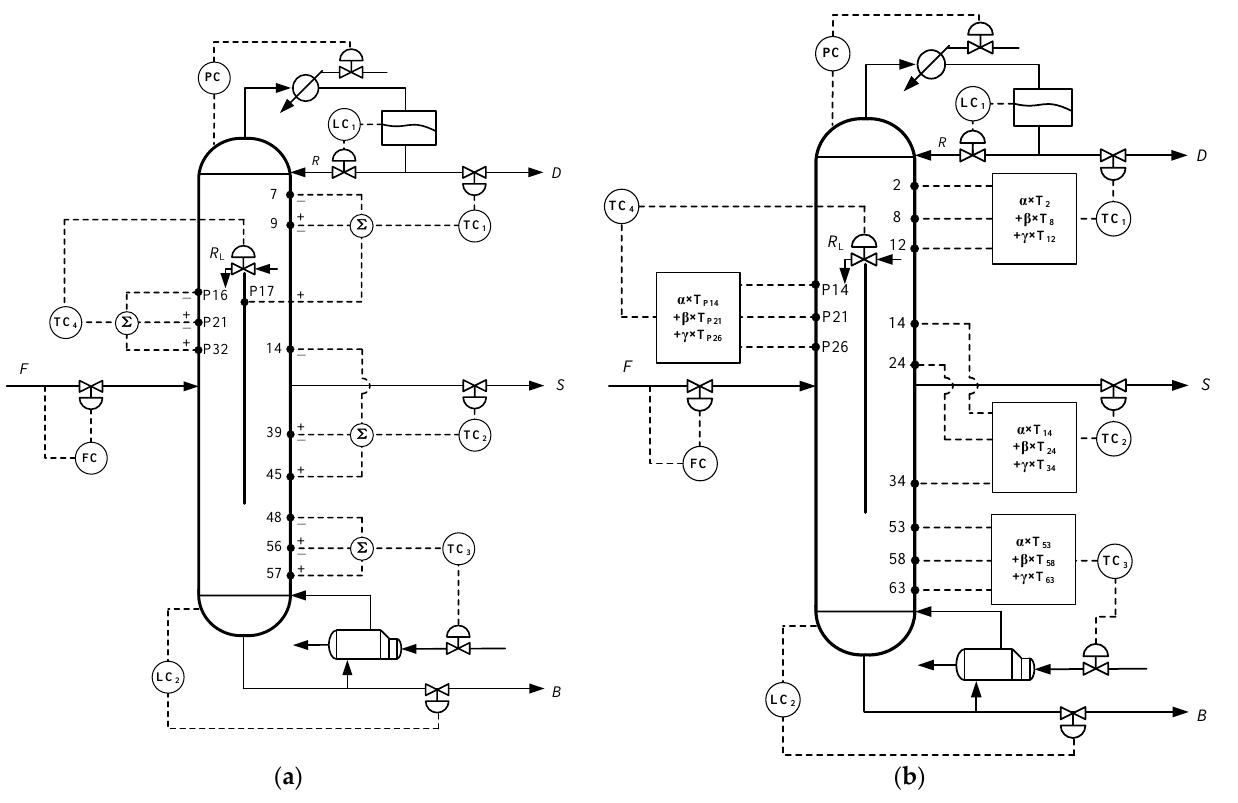
Figure 5. Two temperature inferential control schemes studied (Example I): ( a ) DTDC scheme; ( b ) TC-PQE scheme.